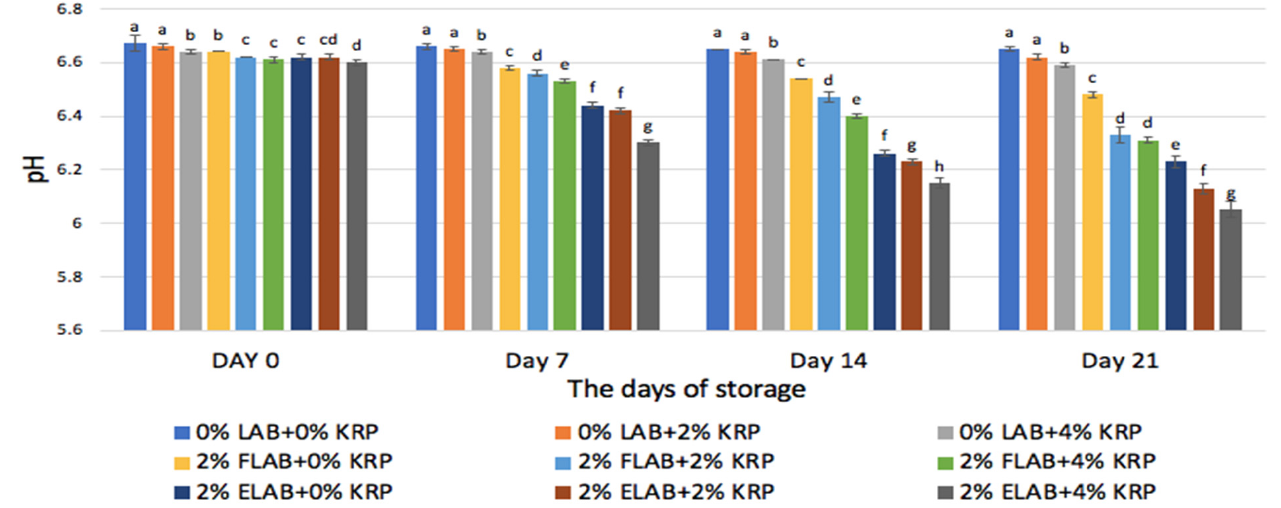
Figure 1. The impact of storage time on the pH of chocolate milk enriched with 0% or 2% LAB and various concentration (0%, 2%, and 4%) of KRP. Columns within each day of measurement with different superscript letters are significantly different (95% confidence level). Table 1. The impact of storage time on the titratable acidity (% lactic acid content) of chocolate milk enriched with 0% or 2% (FLAB or ELAB) and different concentrations (0%, 2% and 4%) of KRP. Data are presented as mean ± standard deviation. Means in a row followed with different superscript letters are significantly different (95% confidence